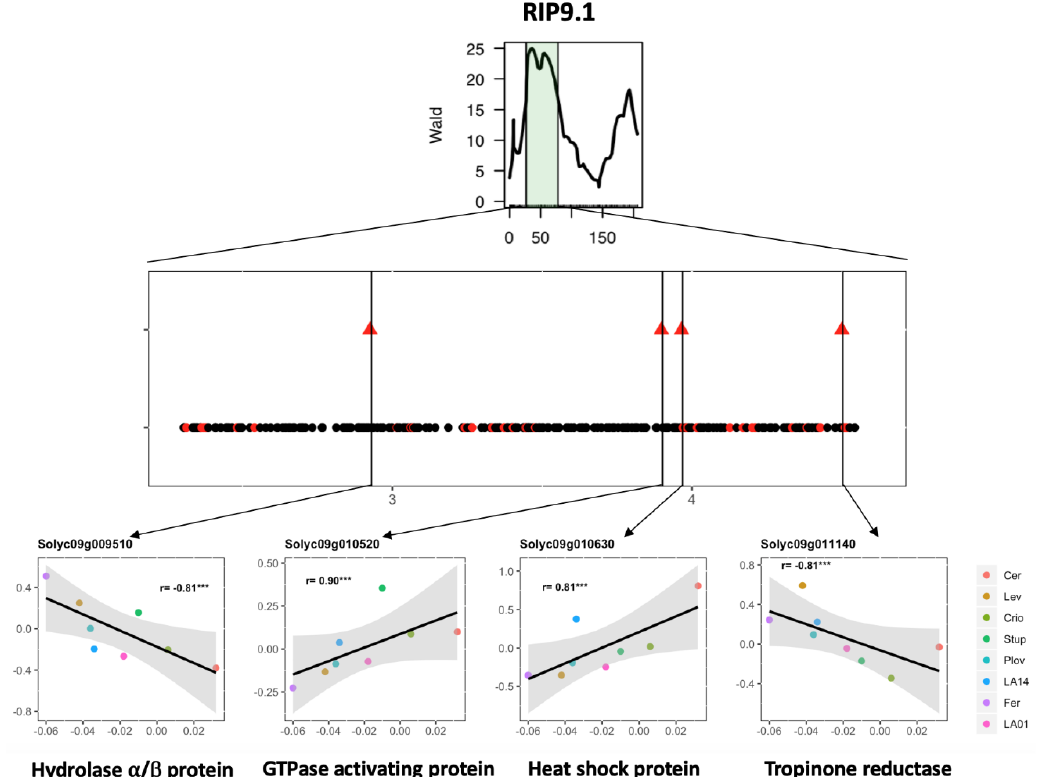
Figure 5. Candidate gene selection for the WD-responsive fruit ripening QTL (RIP9.1) detected in Diouf et al. (2018) [18]. ( Top ) Representation of the RIP9.1 region on chromosome 9 detected using the plasticity of fruit ripening through interval mapping analysis in the MAGIC population. ( Middle ) Genes within the RIP9.1 QTL interval. Black dots represent non-DEGs, and red dots, DEGs in the present study. Triangles represent the DEGs for which the delta expression level (expression level in WD–expression level in control) was significantly correlated to the allelic e ff ect of the QTL for the eight genotypes. ( Bottom ) Correlation between the estimated allelic e ff ect at the QTL ( x -axis) and the delta log2 expression levels ( y -axis) for four candidate genes with their functional annotation.